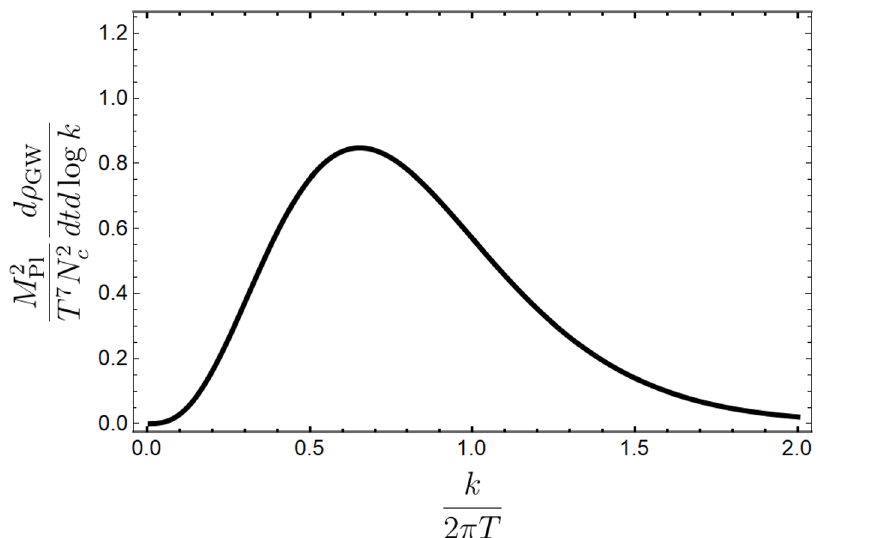
Figure 1 . Energy production rate of gravitational waves as a function of dimensionless frequency κ in N = 4 SYM at strong λ